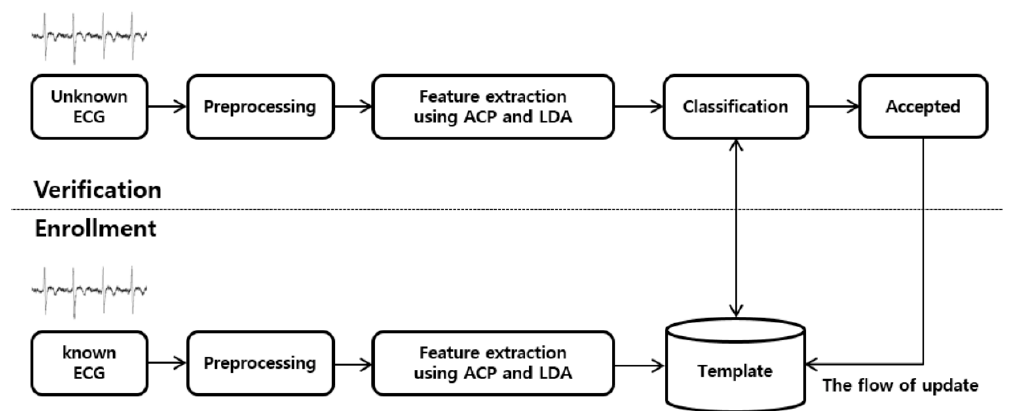
Figure 2. Simplified block diagram of the proposed interval-based LDA algorithm.